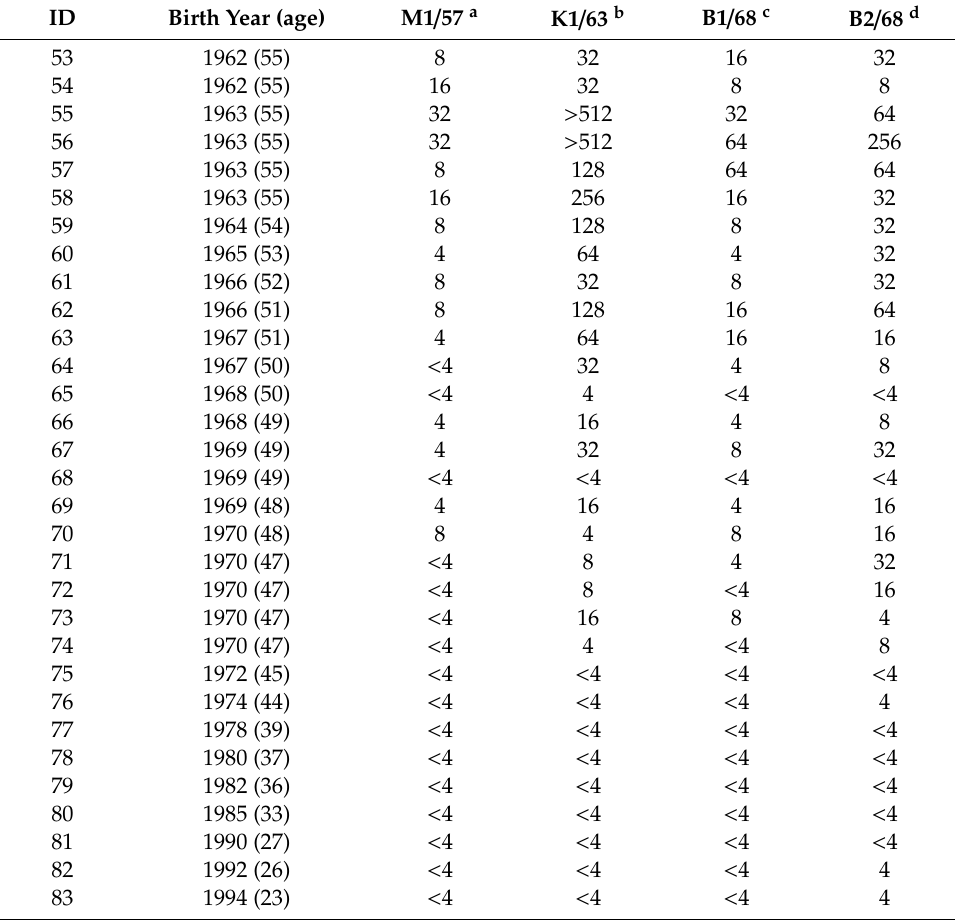
those against B2 / 68, whereas those against M1 / 57 were similar to those against K1 / 63 (Figure 2A,C). The neutralizing titers against K1 / 63 and B2 / 68 of the younger adult individuals were higher than those against M1 / 57 and B1 / 68 (Figure 2B,C). Younger adults who were born after 1972 (ID #75–83) had minimal neutralization titers against the human H2N2 viruses tested (Figure 2C). To visualize the antigenicity of the human H2N2 viruses, we constructed an antigenic map using the neutralizing titers of Table 2. This map revealed the antigenic di ff erences among the H2N2 viruses tested and the gradual drift in their antigenicity during circulation in humans (Figure 3). The results obtained with these human sera were similar to those previously obtained using ferret antisera